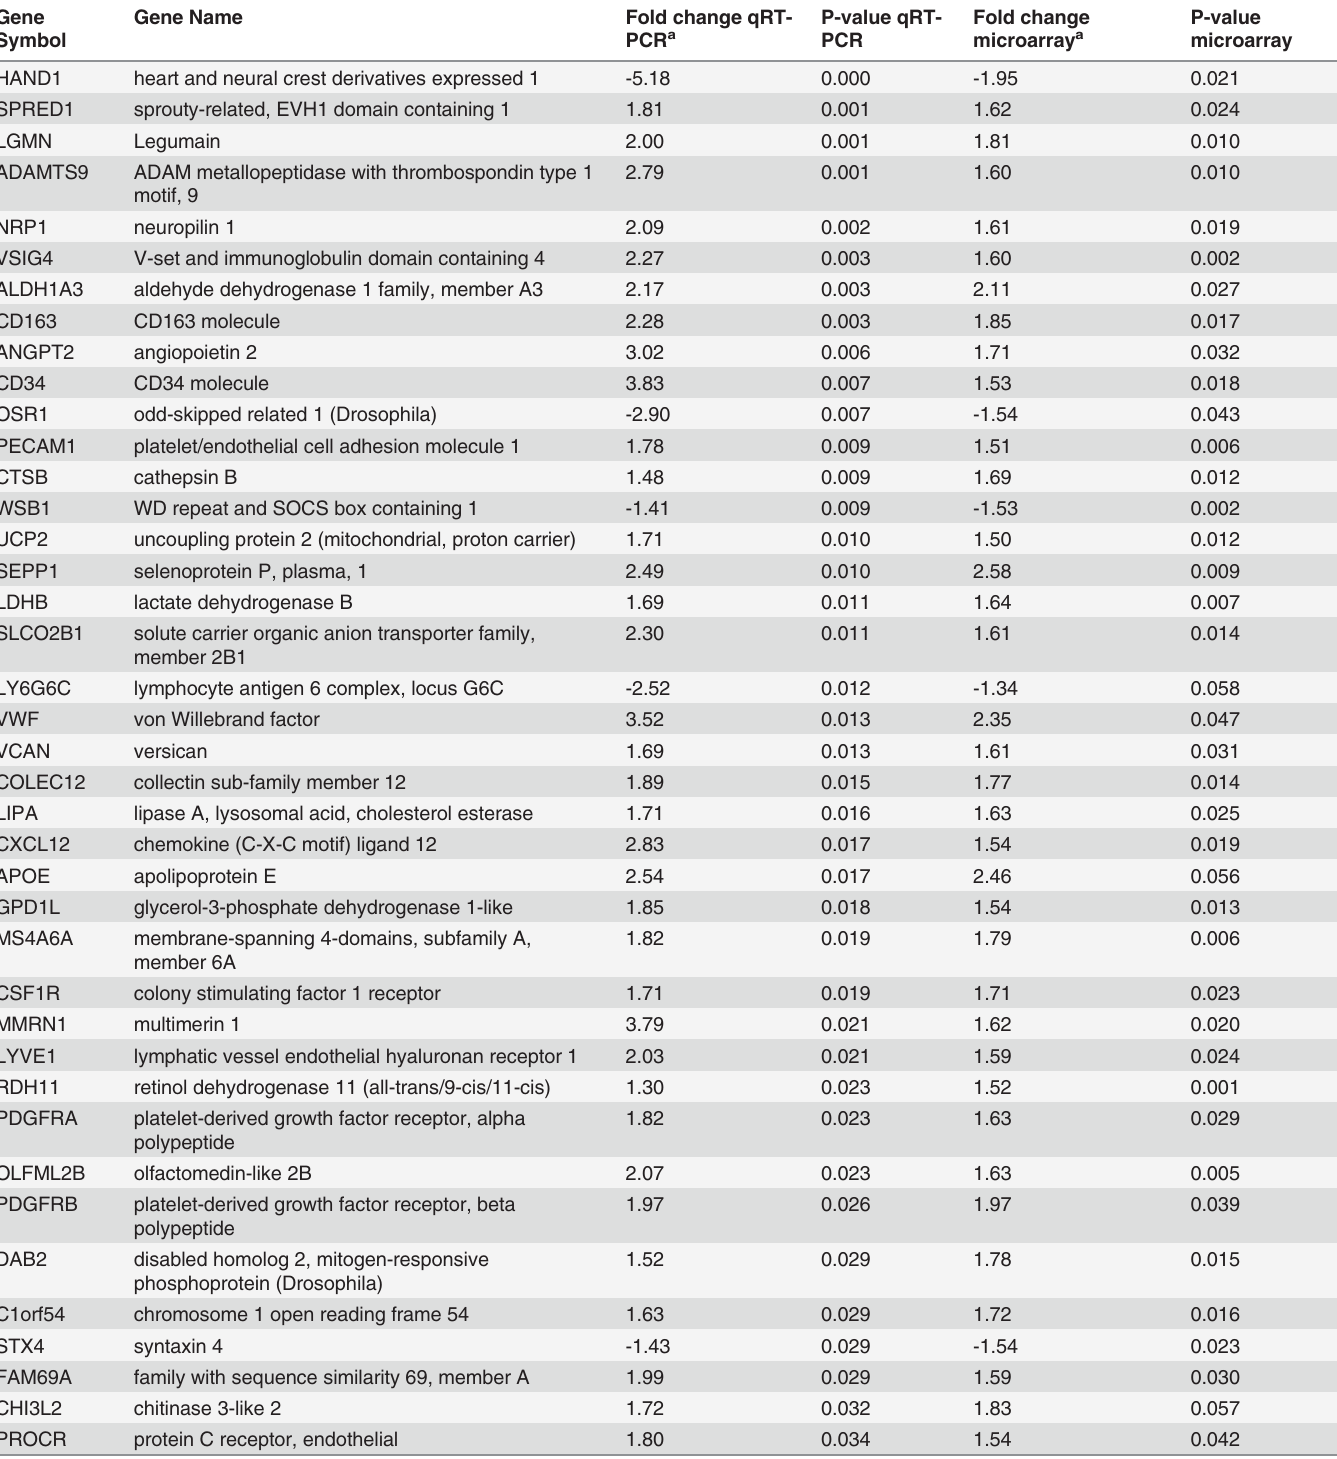
Table 7. Comparison of qRT-PCR and microarray analysis of select genes, with direction of change denoting change in group with neurocognitive impairment. Gene